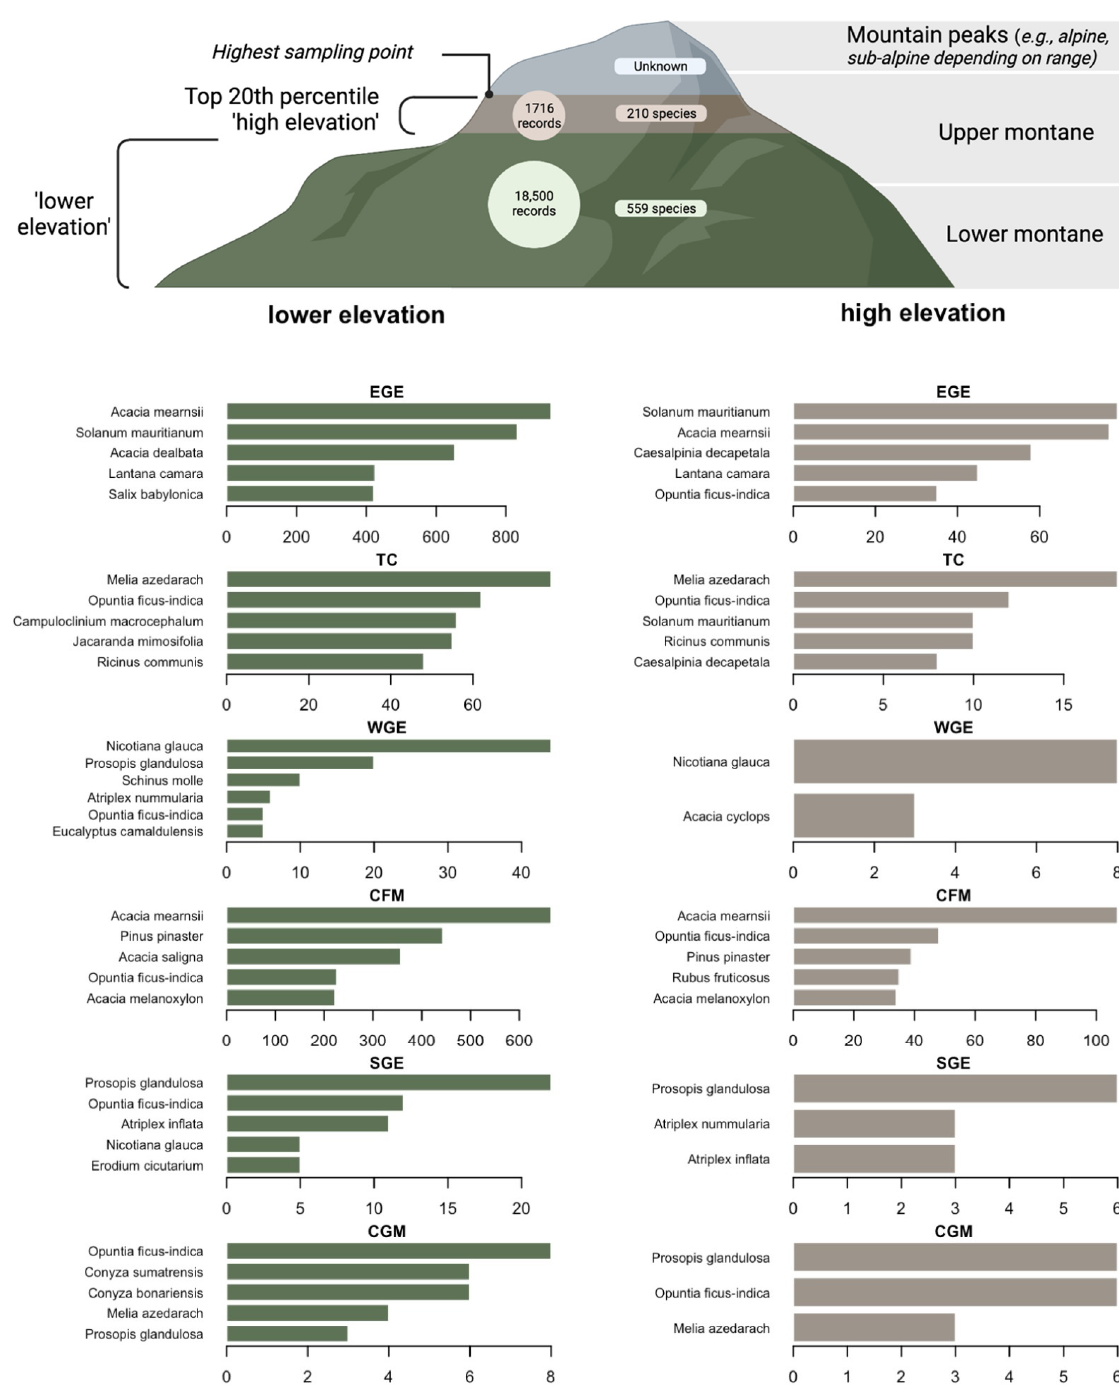
Figure 1. The top five most abundant alien plants recorded in each range in South Africa using SAPIA, iNaturalist and Great Escarpment Data (GED) databases. The high-elevation areas represent the upper 20th percentile elevational area in each range from the highest point recorded in the databases. The maximum elevation (highest peak) and high-elevation delineation for each range was—WGE: 1719 m, 1469 m; TC: 1868 m, 1528 m; EGE: 3446 m, 1651 m; SGE: 1784 m, 1451 m; CGM: 1605 m, 1355 m and CFM: 2064 m, 1667m. The lower elevational area reflect the entire mountain range below the designated high-elevation area. Figure created using BioRender [84].